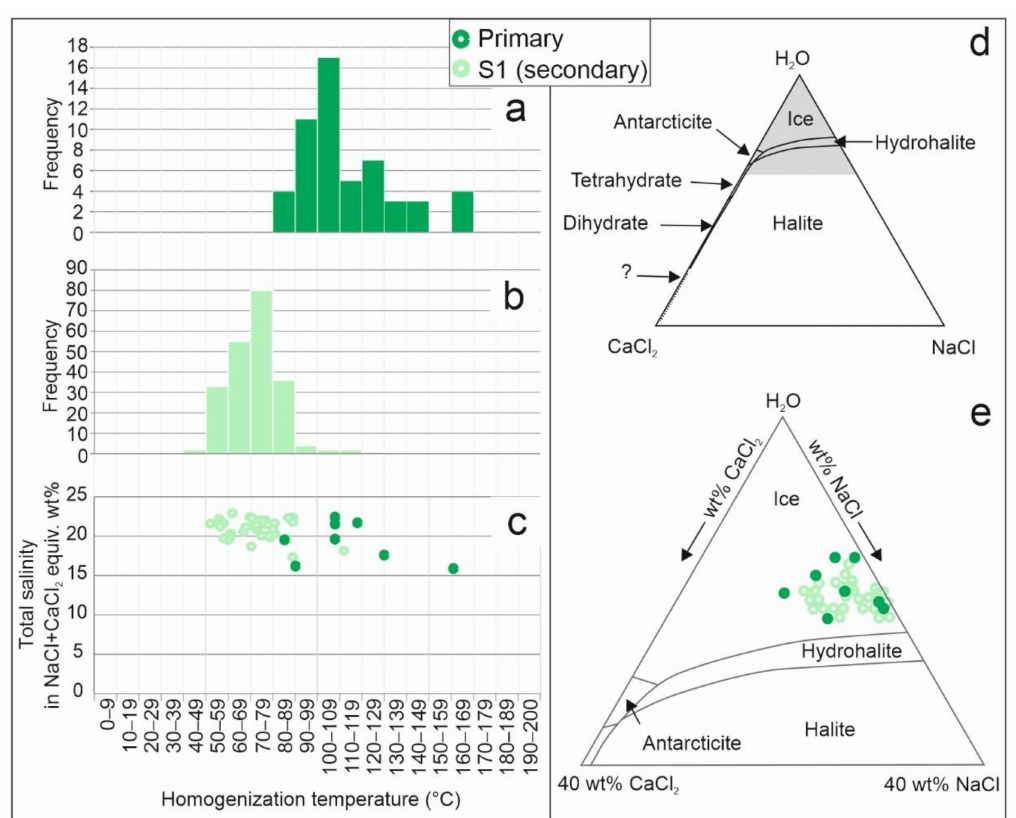
Figure 5. Results of the microthermometry study of primary (P) and S1 (secondary) fluid inclusions. ( a ) Frequency distribution diagram of the homogenization temperature of P inclusions; ( b ) frequency distribution diagram of the homogenization temperature of S1 inclusions; ( c ) homogenization temperature vs. total salinity diagram of P and S1 inclusions; ( d ) vapor-saturated liquidus phase relations in the H 2 O–NaCl–CaCl 2 system [28,29]; ( e ) salinity compositions of aqueous inclusions trapped in fluorite from P é